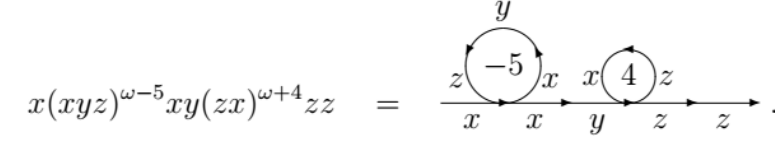
Fig. 1: Pictorial representation if a Z -unary